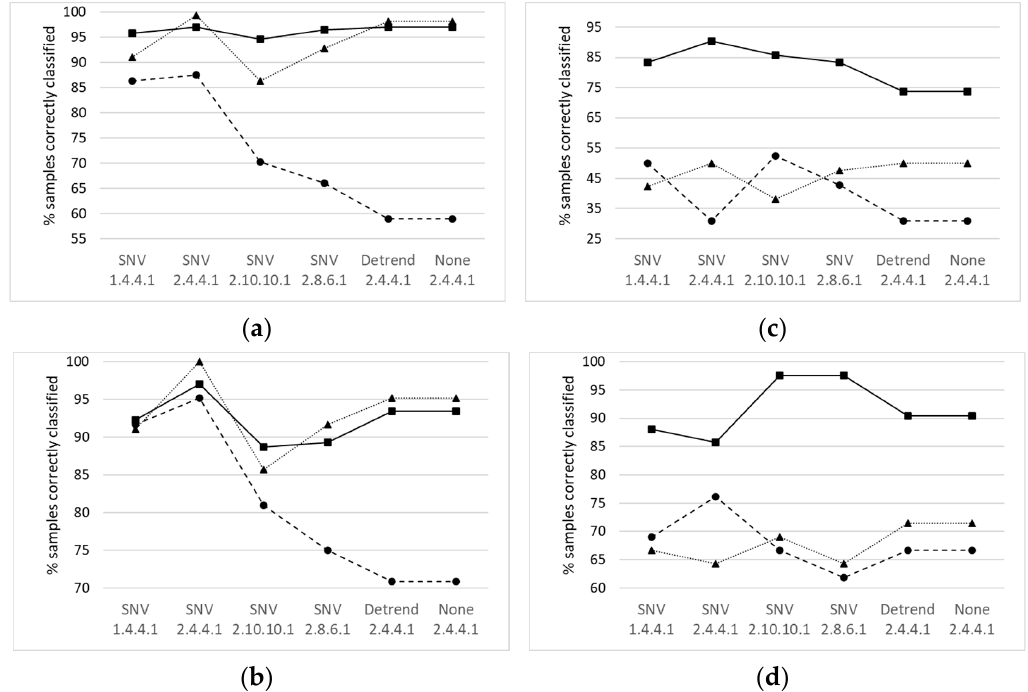
Figure 5. Percentage of samples correctly classified using different mathematical pre-treatments: ( a ) according to the days of montanera and ( b ) according to the breed. Percentage of samples correctly classified in prediction: ( c ) according to the days of montanera and ( d ) according to the breed. Intact fat (1100–2000 nm), Extracted fat (1100–2000 nm) Extracted fat (1100–2498 nm). Table 2. Percentage of samples correctly classified (in bold) according to the days of montanera and breed by NIRS.